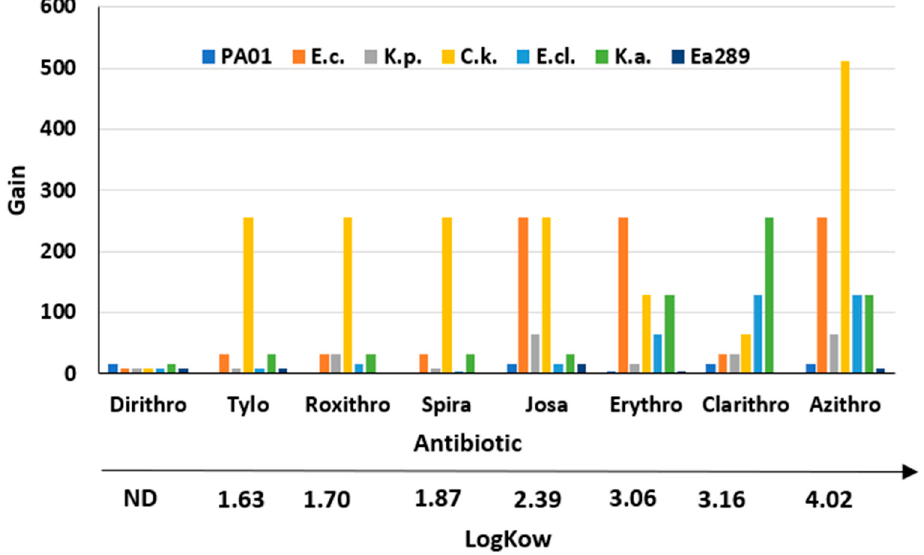
Figure 2. Correlation of the gain factor observed toward numerous Gram-negative bacteria depending on the LogKow value of the considered macrolide antibiotic.